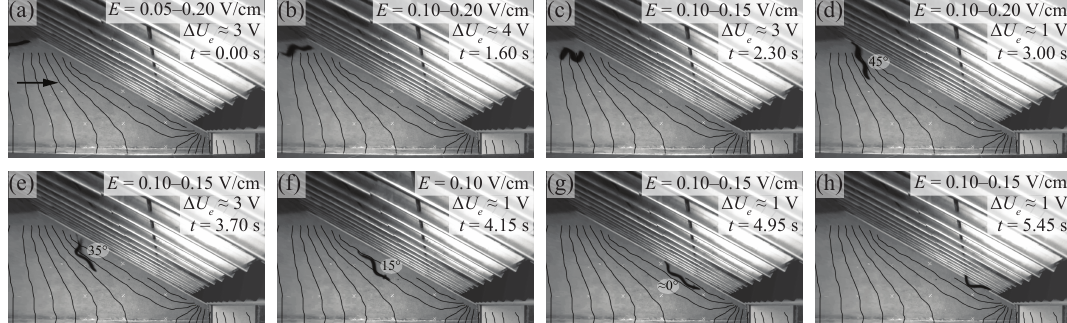
Figure 11. Typical rack passage of an eel ( Anguilla anguilla ) with TL = 57 cm at the e-HBR with s b = 51 mm and U e = 38 V, where the eel approached the rack with a negative rheotaxis, was guided towards the rack, but passed through the e-HBR when it was oriented rack-parallel; the equipotential lines are visualized in black. The approximate voltage gradient E at the position of the eel, the body voltage ∆ U e and the timeline are given in the top right